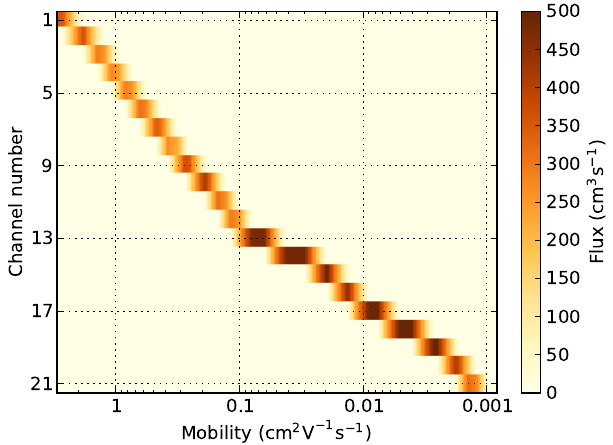
Fig. 5. Analyzer response G(i, z) for the NAIS. It can be seen that the responses for individual channels are